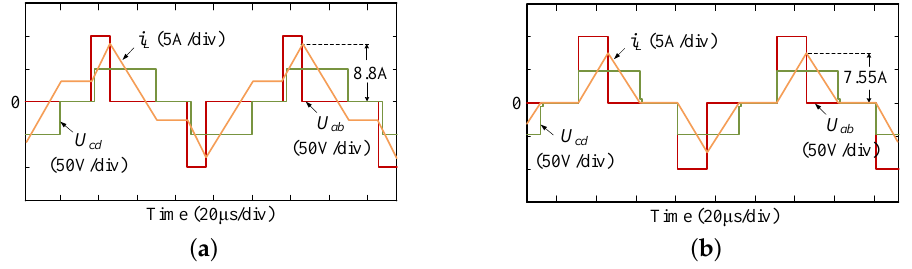
Figure 5. Simulation waveforms of DAB converter with U 1 = 100 V, U 2 = 50 V, and P = 125 W: ( a ) D 1 = 0.68, D 3 = 0.37, and M = 0; and ( b ) D 1 = 0.58, D 3 = 0.37, and M =